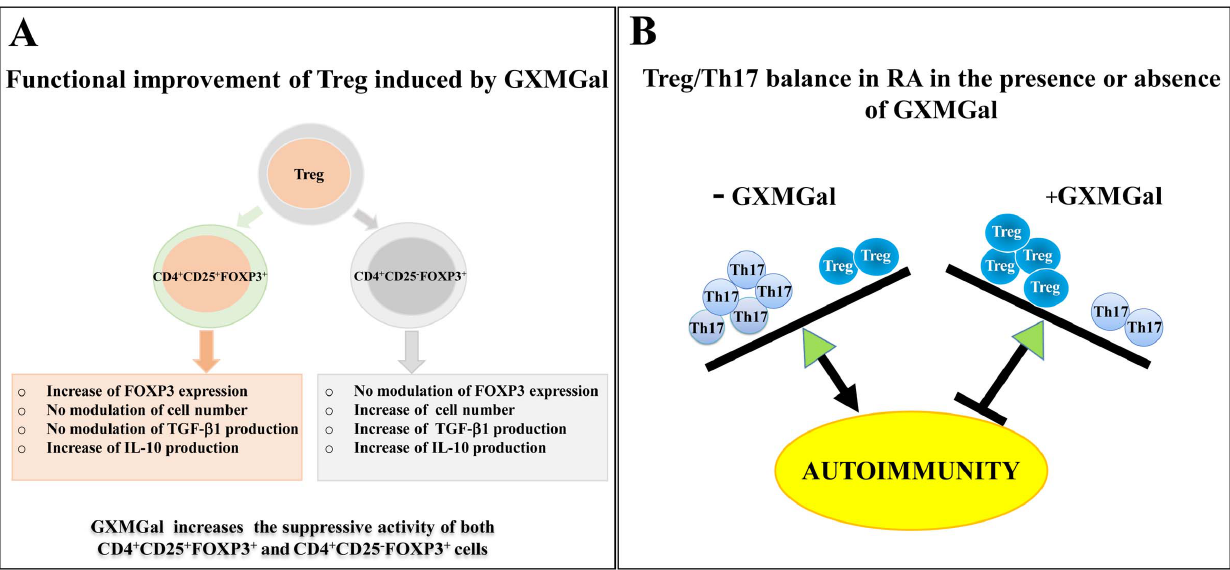
Figure 7. Schematic representation of GXMGal effects on Treg (A) and on Treg/Th17 balance (B).